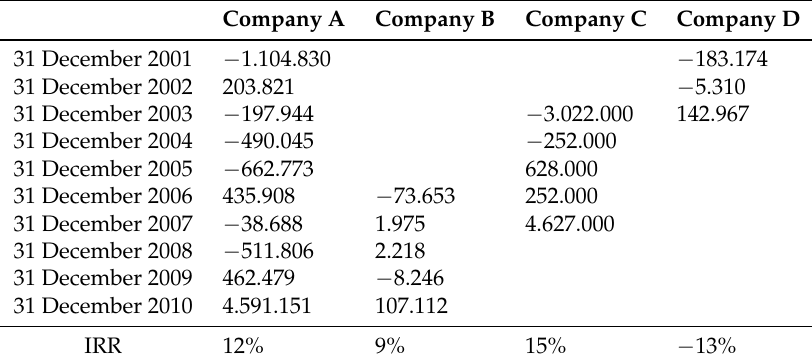
Table 1. Numerical examples of the internal rate of return (IRR)